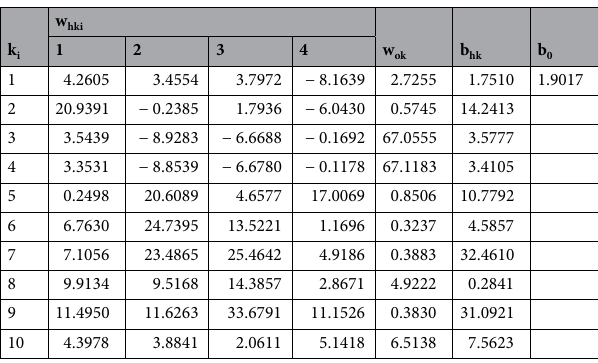
Table 9. Connection weights and bias.